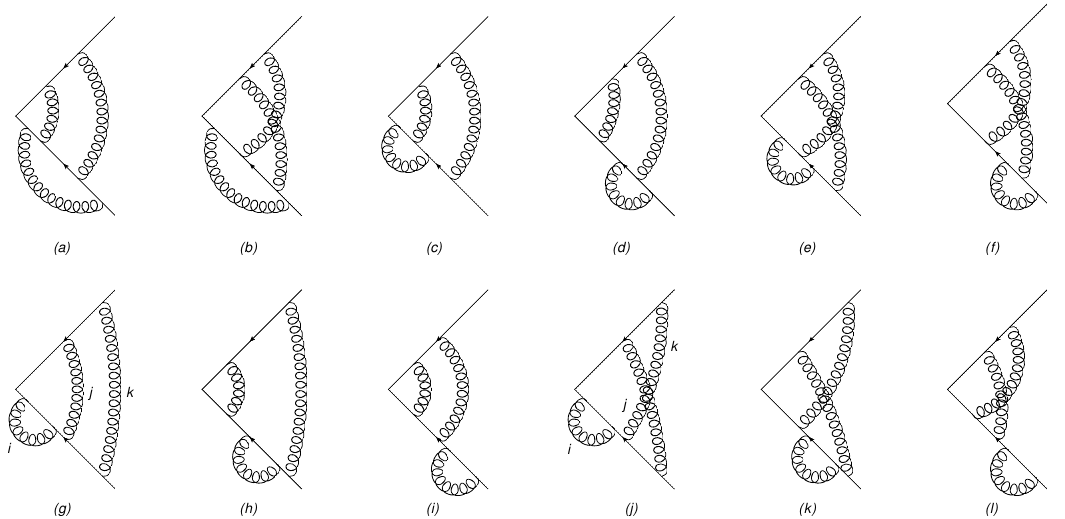
Figure 4 . The (2,4) web, where we have assigned replica indices to the gluons in diagrams ( g ) and ( j ) . Although not drawn here, it is assumed that additional Wilson lines emanate from the Wilson-line